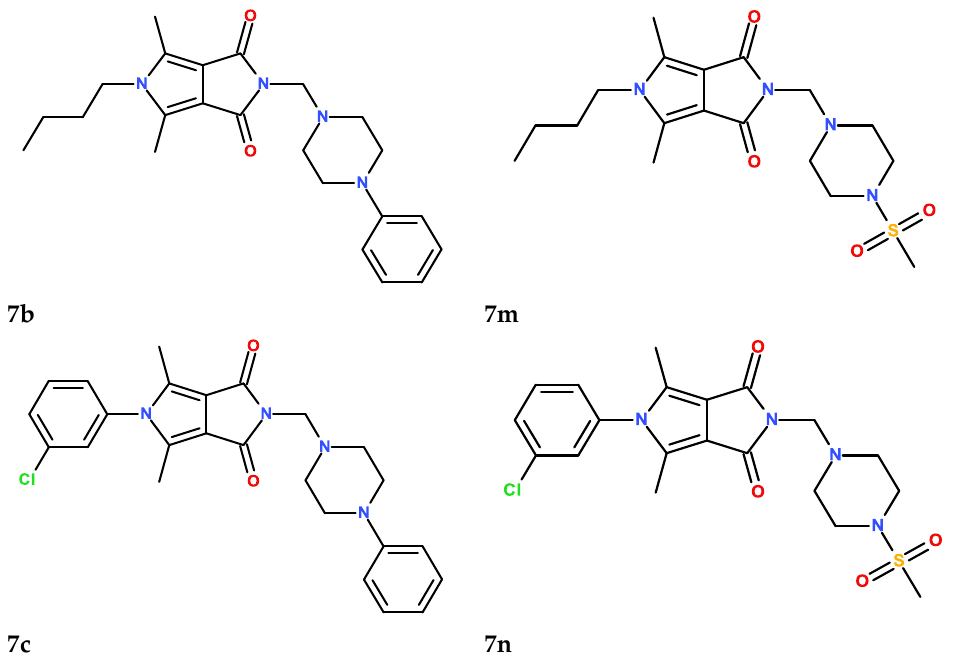
Figure 1. The structures of the six ( 7a – 7c , 7l – 7n ) investigated N -Mannich base derivatives of pyrrolo[3,4- c ]pyrrole.